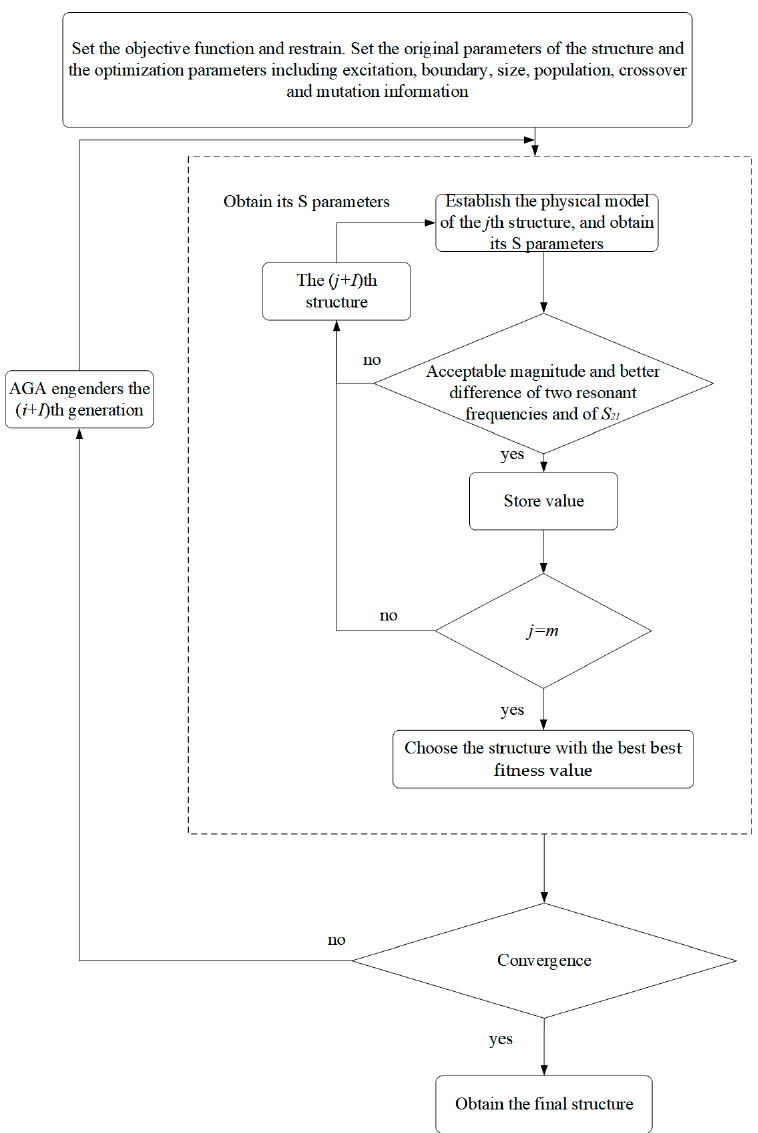
Figure 1. The flowchart based on AGA.